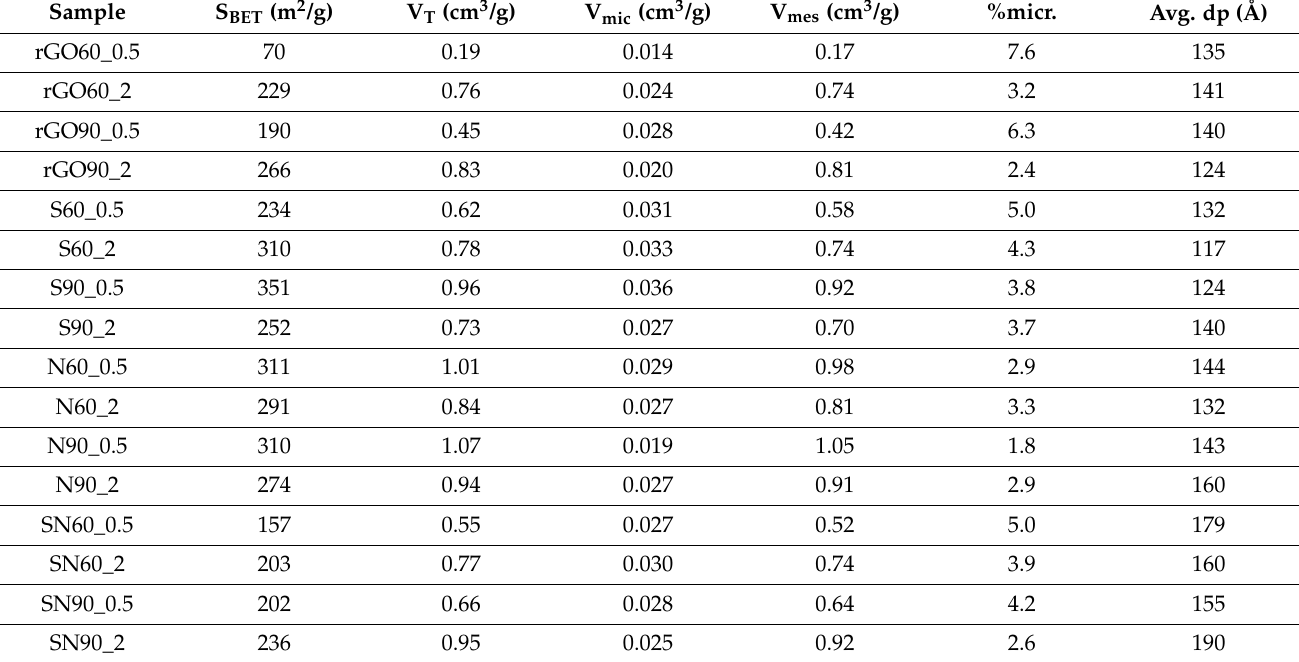
Figure 5. SA of all samples for different parameters and modifications during preparation. Labels of B, N, S, and SN represent the blank system, systems modified with TMON, systems modified with TMOS, and systems modified with TMOSN, respectively. Table 3. Porosity results for all samples.